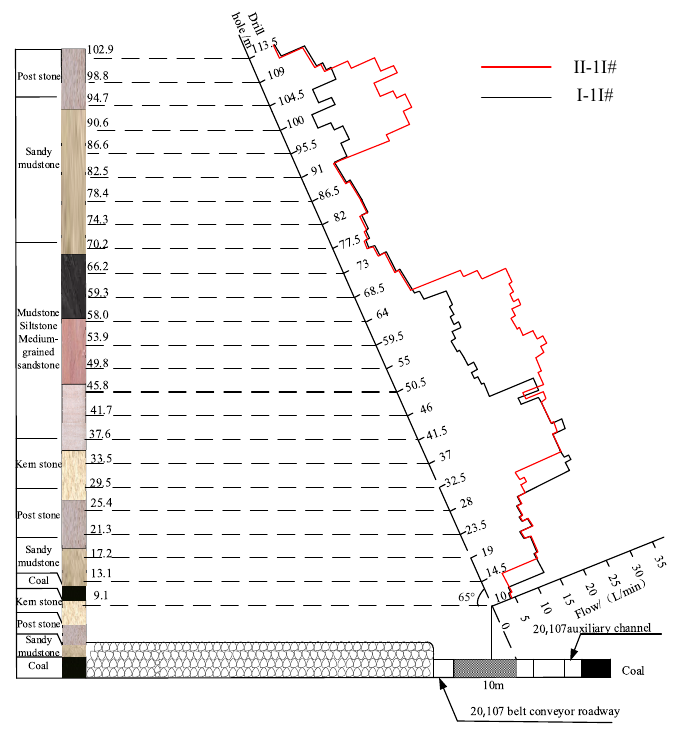
Figure 11. I-2# and II-2# Borehole Leakage Histogram.